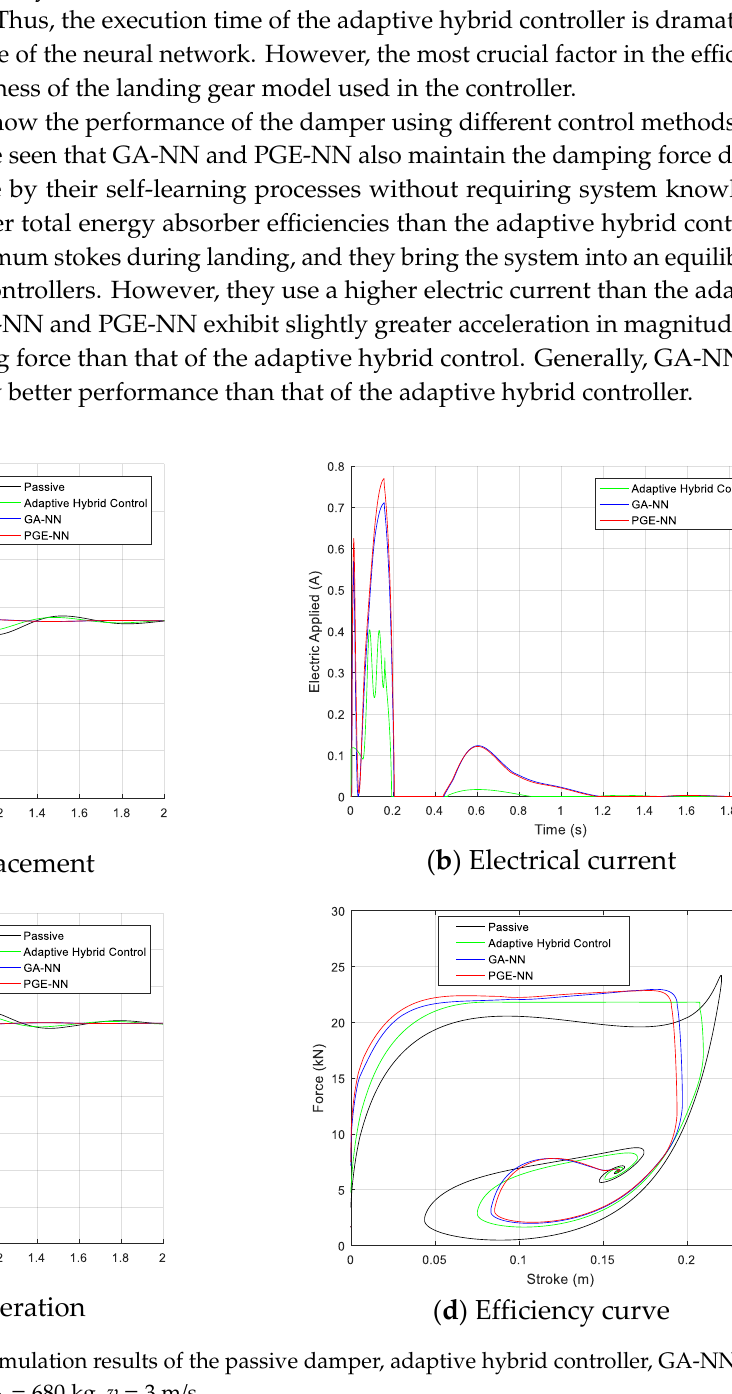
Table 4. Efficiency of the landing gear using the passive damper, adaptive hybrid control, GA-NN, and PGE-NN in the case of m 1 = 680 kg and v = 3 m/s.